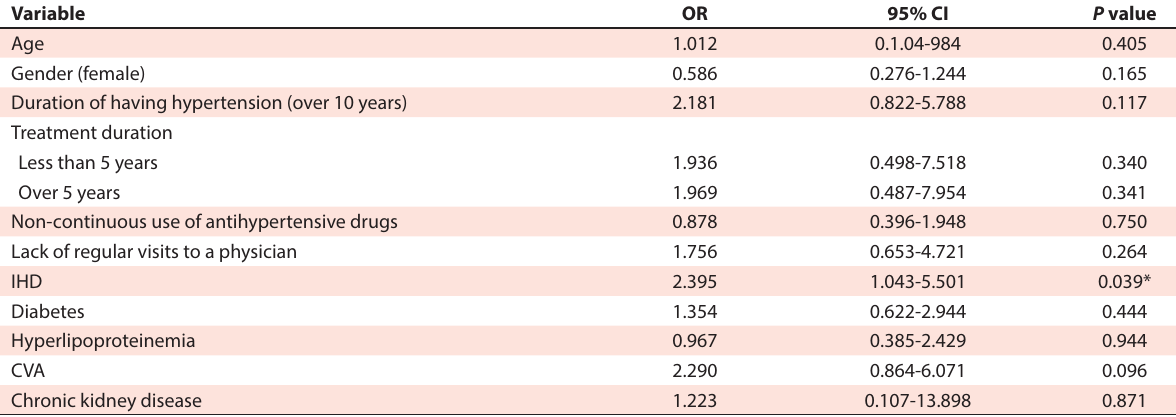
Table 3. Univariate logistic regression between ICH volume and the studied factors Variable